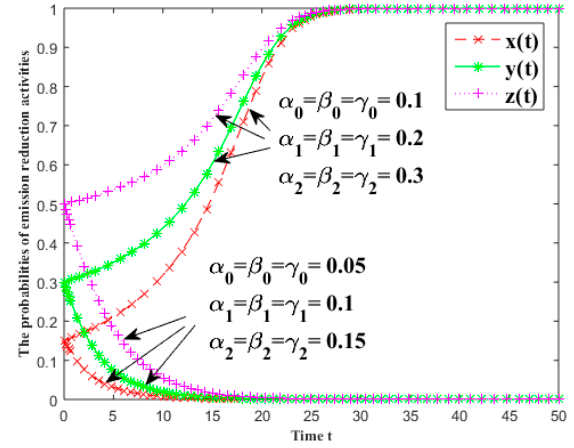
Figure 6. The effects of the rate of return of emission reduction input on the probabilities of emission reduction activities.